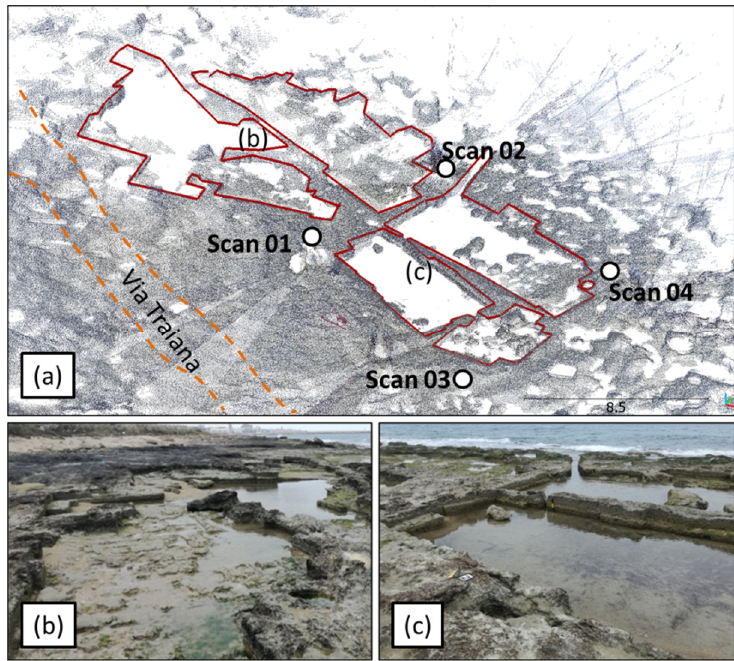
Figure 4. Topographic survey at Mola di Bari; ( a ) TLS point cloud of the coastal quarries of Mola di Bari with the delimitation of the main architectural elements that define their functional height; ( b ) quarries carved in the proximity of the Via Traiana; ( c ) quarries connected to the sea through a drainage channel.